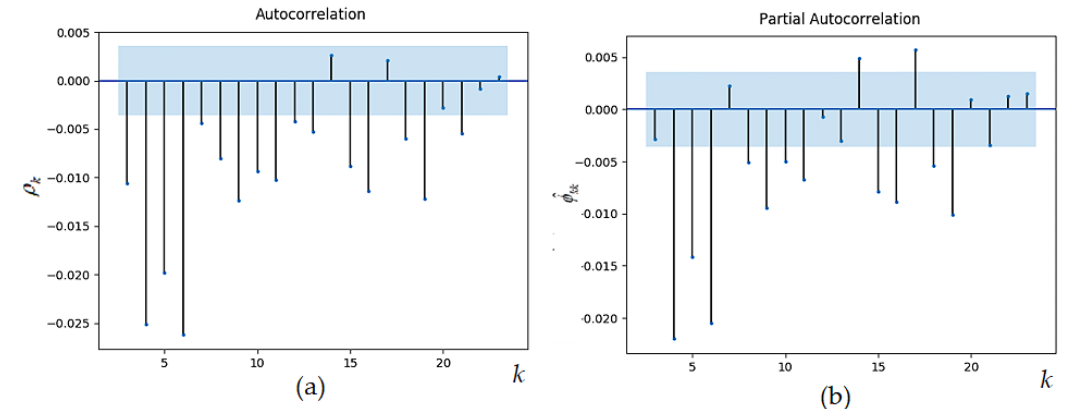
Figure 2. Sample autocorrelation ( a ) and partial autocorrelation function ( b ) for the first difference of